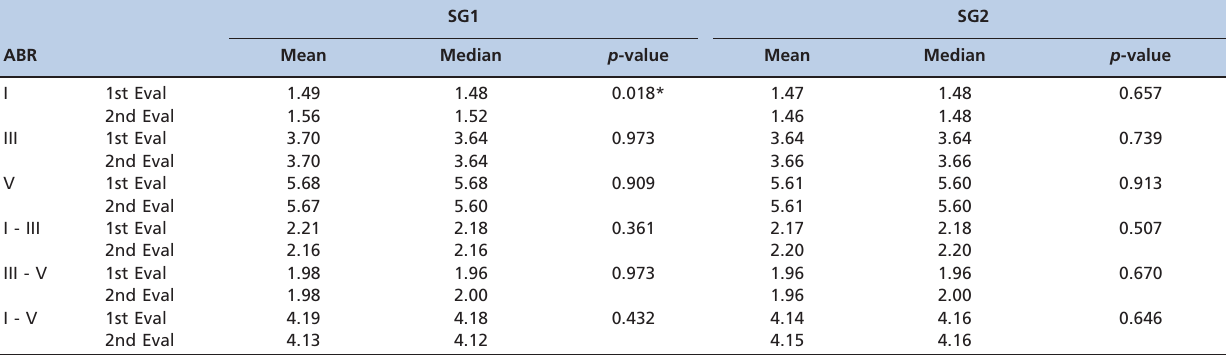
Table 2 - The comparisons between the first and second evaluations regarding the wave I, III, and V and I-III, III-V, and I-V interpeak ABR latencies for subgroups SG1 and